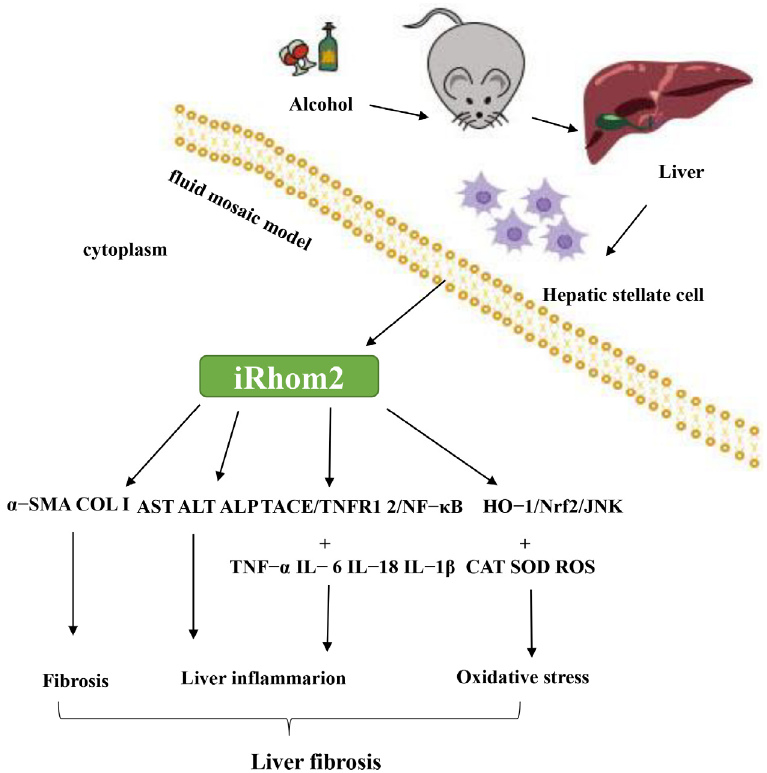
Figure 7. Models showing that iRhom2 is a positive regulator of alcohol-induced liver fibrosis; iRhom2 plays an important role in regulating the progression of liver fibrosis in alcohol-exposed mice, most likely by activating the TACE/TNFRs/NF- κ B signaling pathway to promote inflammation. In addition, iRhom2 exacerbates liver fibrotic lesions by activating JNK expression to enhance oxidative stress via the Nrf2/HO-1 pathway.